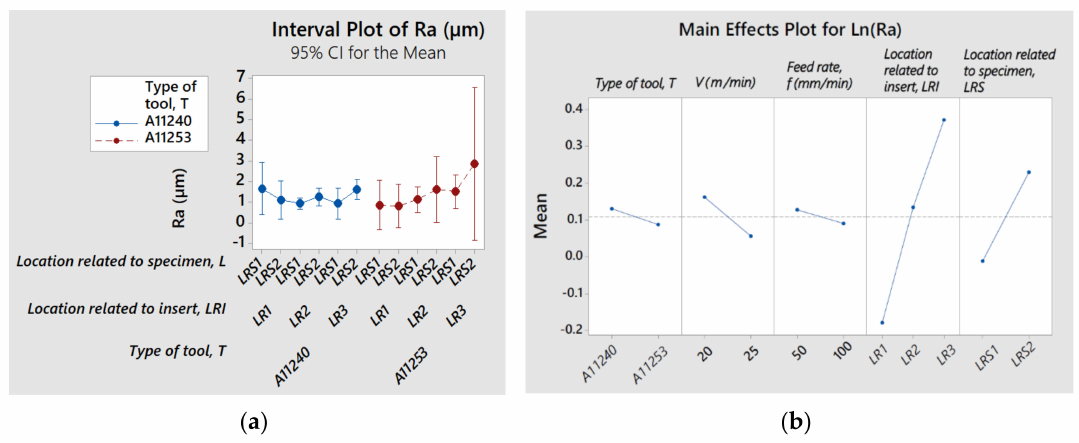
Figure 6. Mg-Ti-Mg test. ( a ) Multiple interval plot with groups: tool type, T , Location Regarding Insert, LRI , and Location Regarding Specimen, LRS ; ( b ) main e ff ects over Ln Ra . Based on data from